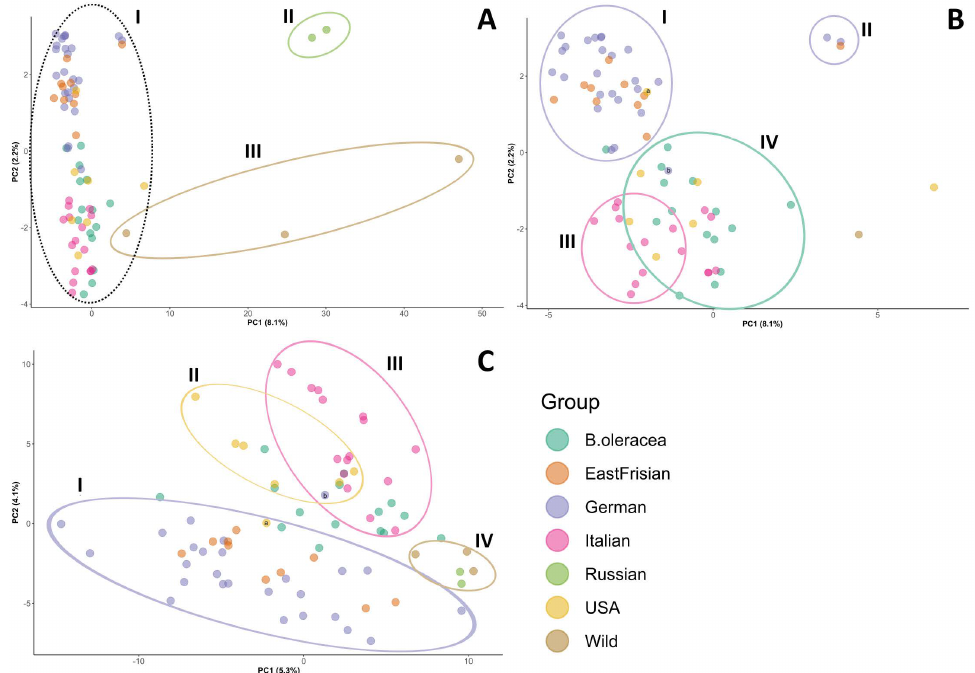
Figure 2. Principal components score plot showing PC 1 and PC 2 of PCA results for the samples obtained from ( A ) + ( B ) SNP data of the filtered dataset, and ( C ) using the SPLoSH information. The proportion of the total variance that is explained by the first (PC 1) and second (PC 2) principal component is indicated in brackets. Part ( B ) is a magnification of the dotted cluster. Details on the observed clusters (Latin numbers) are explained in the text. Each point represents one sample. Plots labelled with sample names are provided as Supplementary Figure S3. “a” = Olympic Red, “b” = Dutch